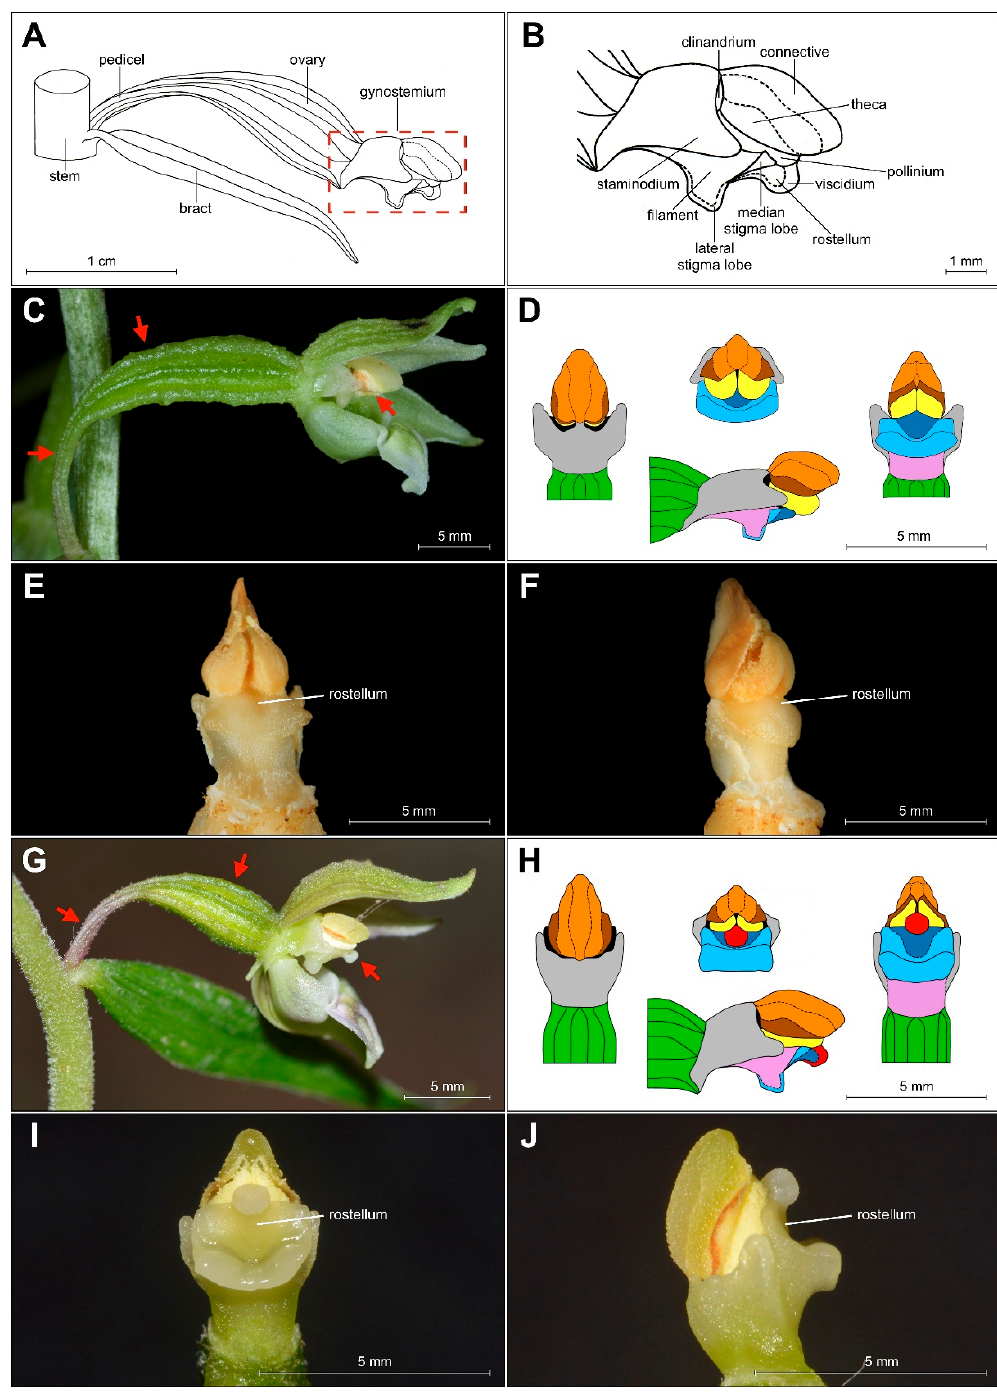
Figure 5. ( A – B ) Scheme of Epipactis gynostemium, side view. Differences in morphology of gynostemium between E. greuteri (material preserved in alcohol) ( C – F ) and E. helleborine (fresh plant) ( G – J ). Various elements of the gynostemium morphology are marked on ( D ) and ( H) in the different colors: orange—connective, brown—theca, red—viscidium, dark blue—rostellum, light blue—median/lateral stigma lobe, violet/pink—filament, green—ovary, black—clinandrium, yellow—pollinium; red arrows mark important characters: pedicel, ovary, and viscidium (the last presented only in E. helleborine ).